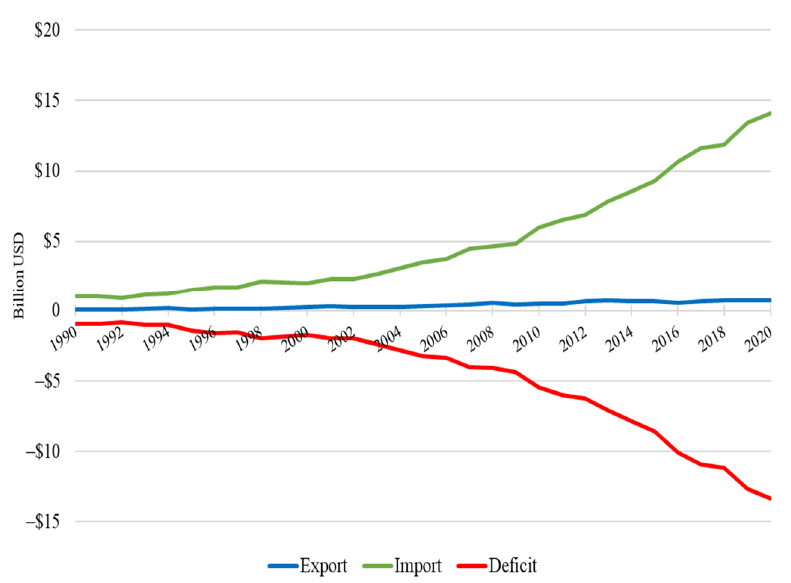
Figure 3. U.S. fresh fruit and vegetables trade with Mexico from 1990 to 2020. Source: USDA FAS